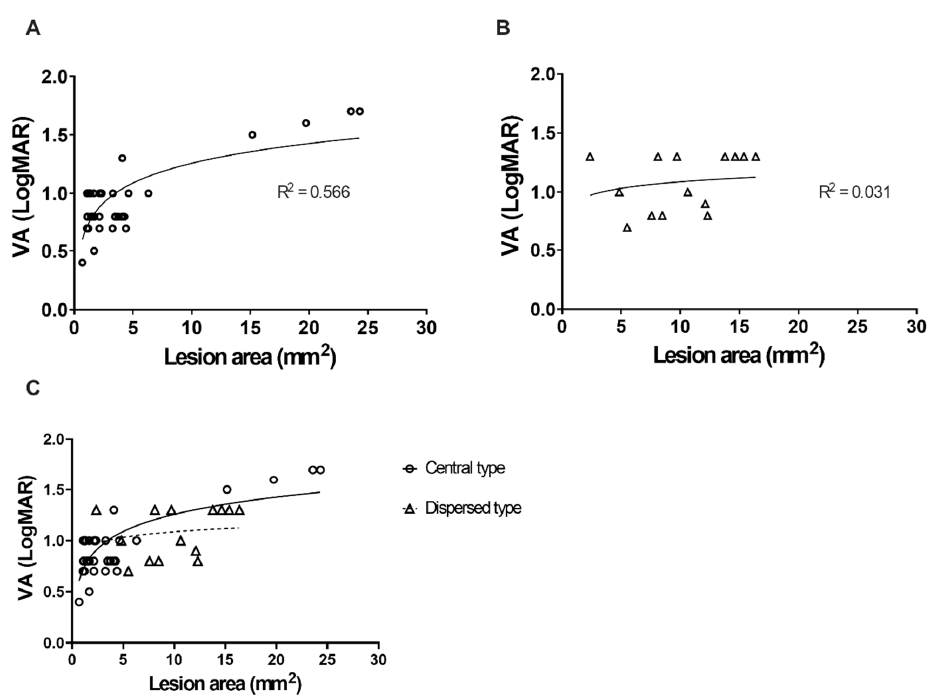
Figure 3. Fundus autofluorescence lesion areas and the visual acuity of patients with Stargardt disease 1. ( A ) Central type Stargardt disease 1. ( B ) Dispersed type Stargardt disease 1. ( C ) Comparison of the central type and dispersed type lesion areas and visual acuity of each patient.